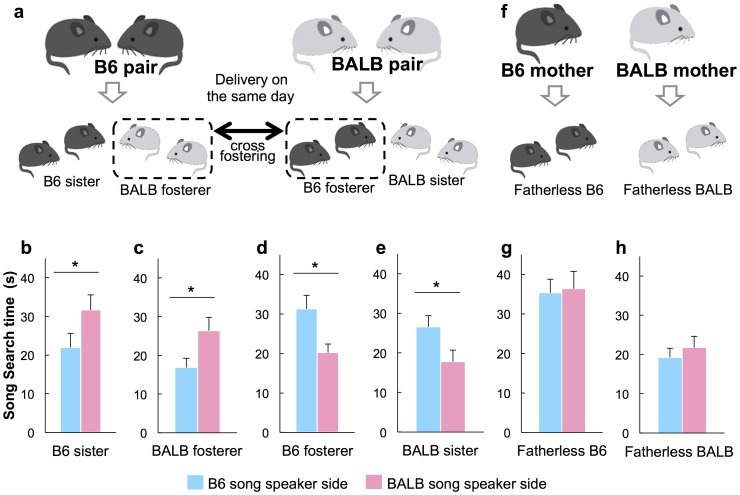
Cross-fostering reversed, and fatherless rearing diminished, female song preference.(a) Experimental scheme of the cross-fostering paradigm. Part of the litter (B6-fosterer and BALB-fosterer) was reciprocally cross-fostered to parents of the other strain of mice. (b–e) B6 sister (n = 10) and BALB-fosterer (n = 15) showed longer search times for BALB song. In contrast, B6-fosterer (n = 16) and BALB sister (n = 14) treated with ESP1 prior to the experiment showed longer search times for B6 song. GLM with fosterer/sister and male song as factors revealed significant effects of the interaction. (f) Fatherless B6 and fatherless BALB ware raised by mothers only. (g–h) There was no significant difference in search time for B6 and BALB songs in fatherless B6 and BALB females. Values represent means+standard error. Asterisks indicate significant differences p<0.05.